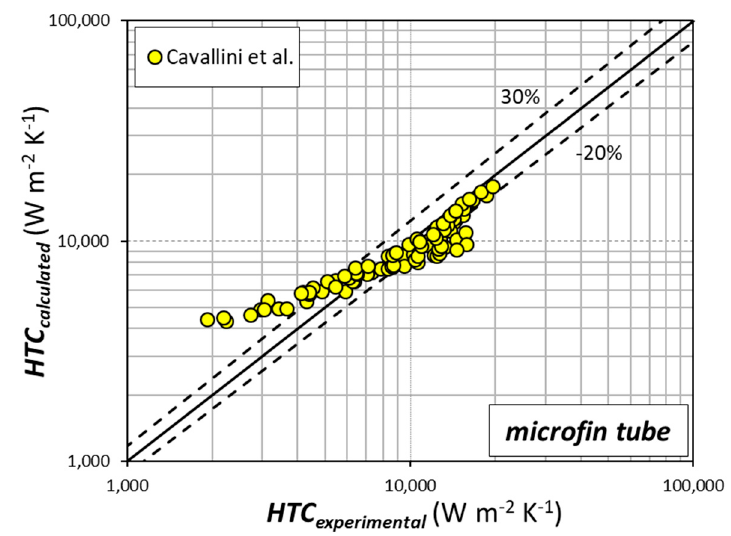
Figure 12. Experimental and calculated heat transfer coefficients for the 2.4 mm ID microfin tube. Model developed by Cavallini et al. [26].